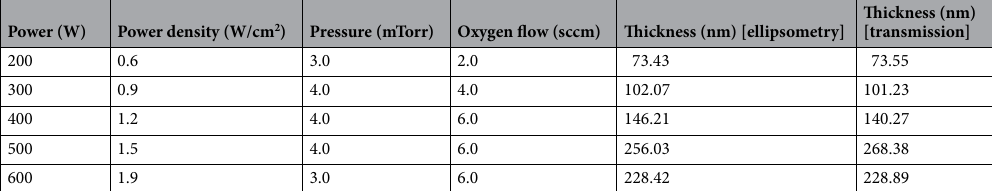
Table 6. A comparison of thicknesses obtained from ellipsometry and optical transmission measurements.